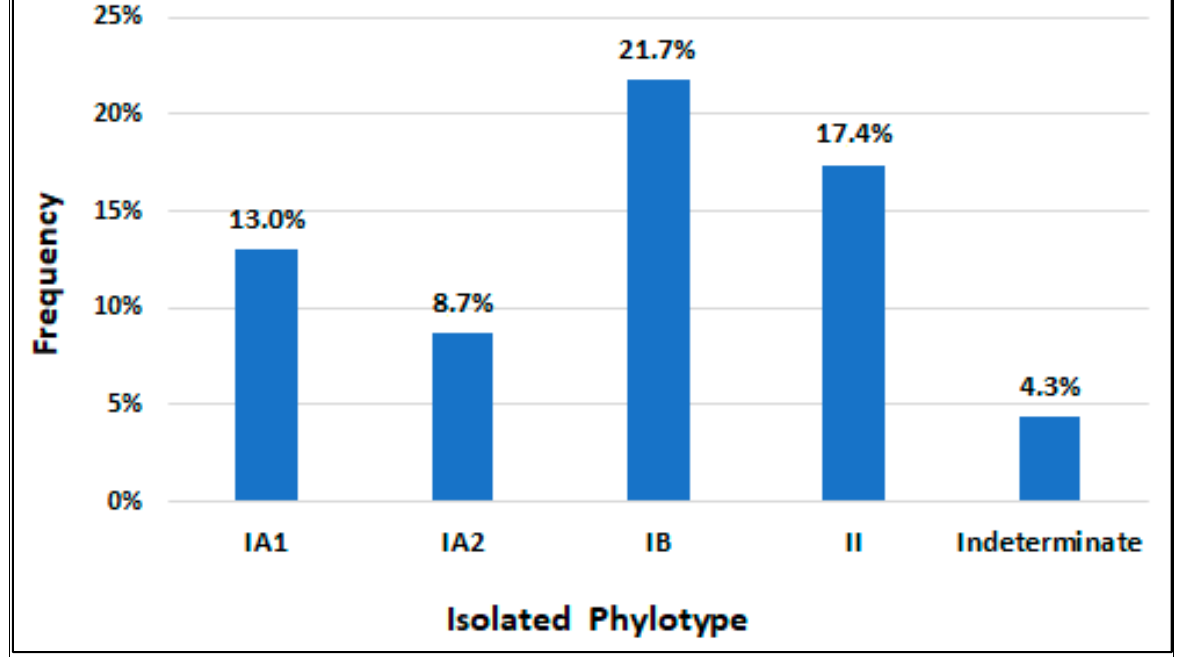
Figure 1. Frequency of Cutibacterium acnes phylotypes isolated.